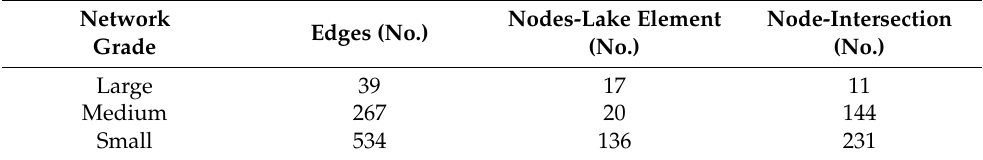
Figure 7. Grading results for the river system networks: ( a ) large, ( b ) medium, and ( c ) small networks. Table 10. Statistics for the river system network elements with different